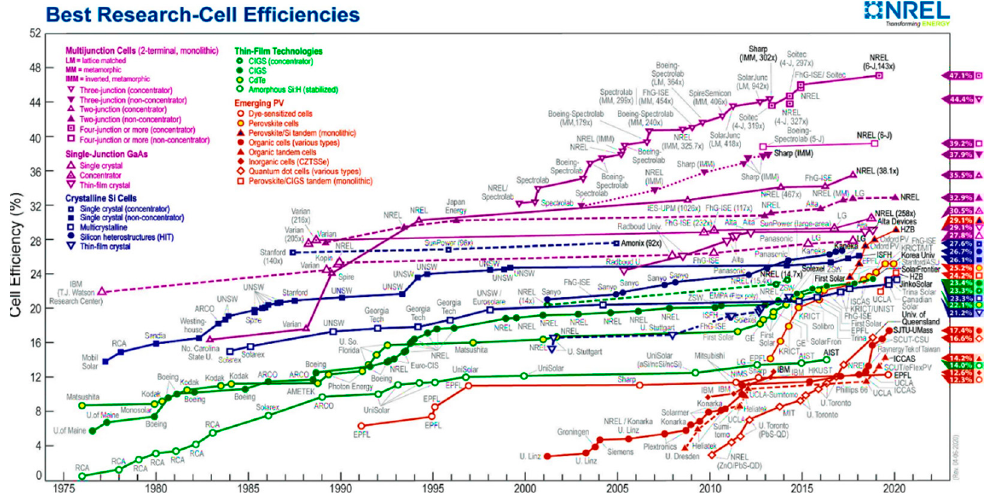
Figure 3. Cell efficiency progress trend of various PV devices (This plot is courtesy of the National Renewable Energy Laboratory, Golden, CO) [44].